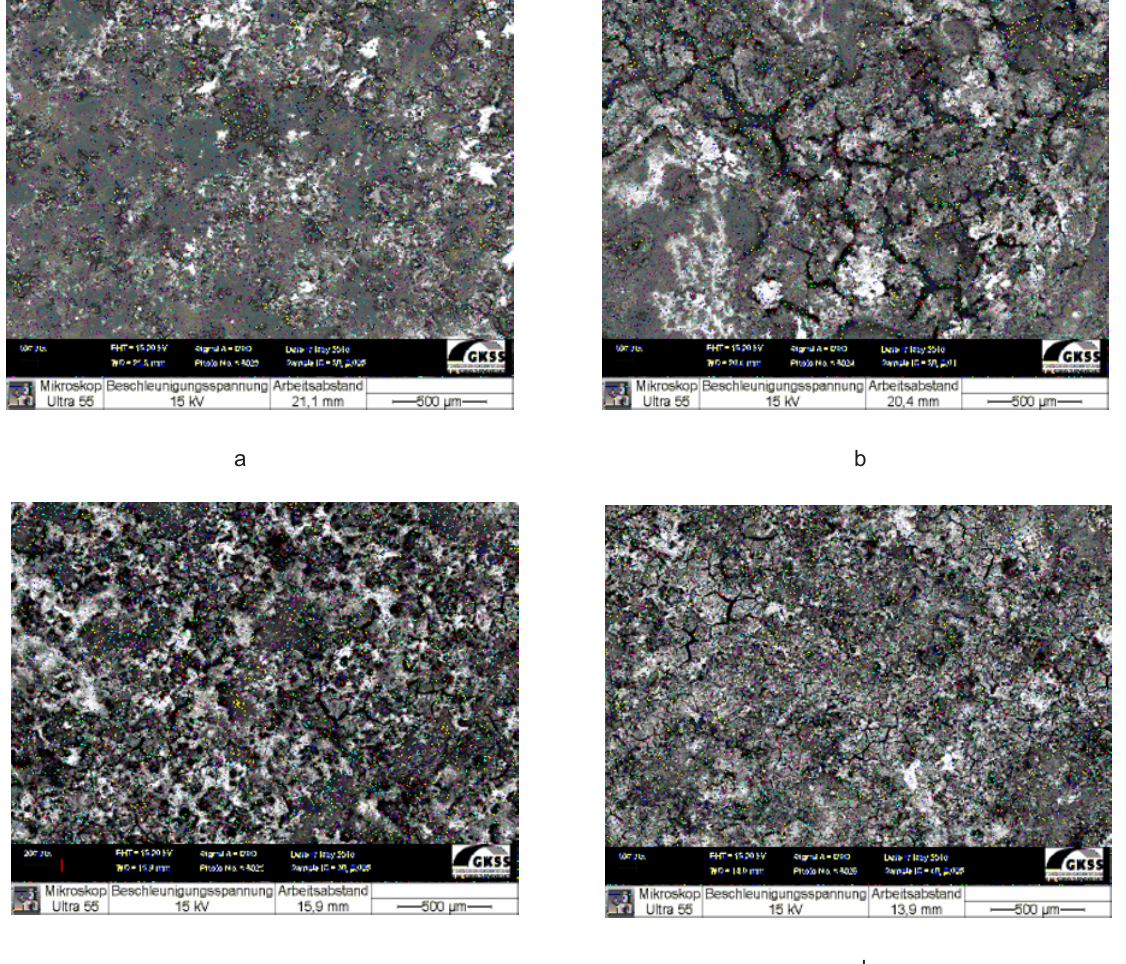
Figure 2. SEM micrographs of magnesium disk surface after cementation in 0.005 M (a, c, d) and 0.01 M [Ag(S temperatures were: 20 o C (a, b), 30 o C (c) and 40 o C